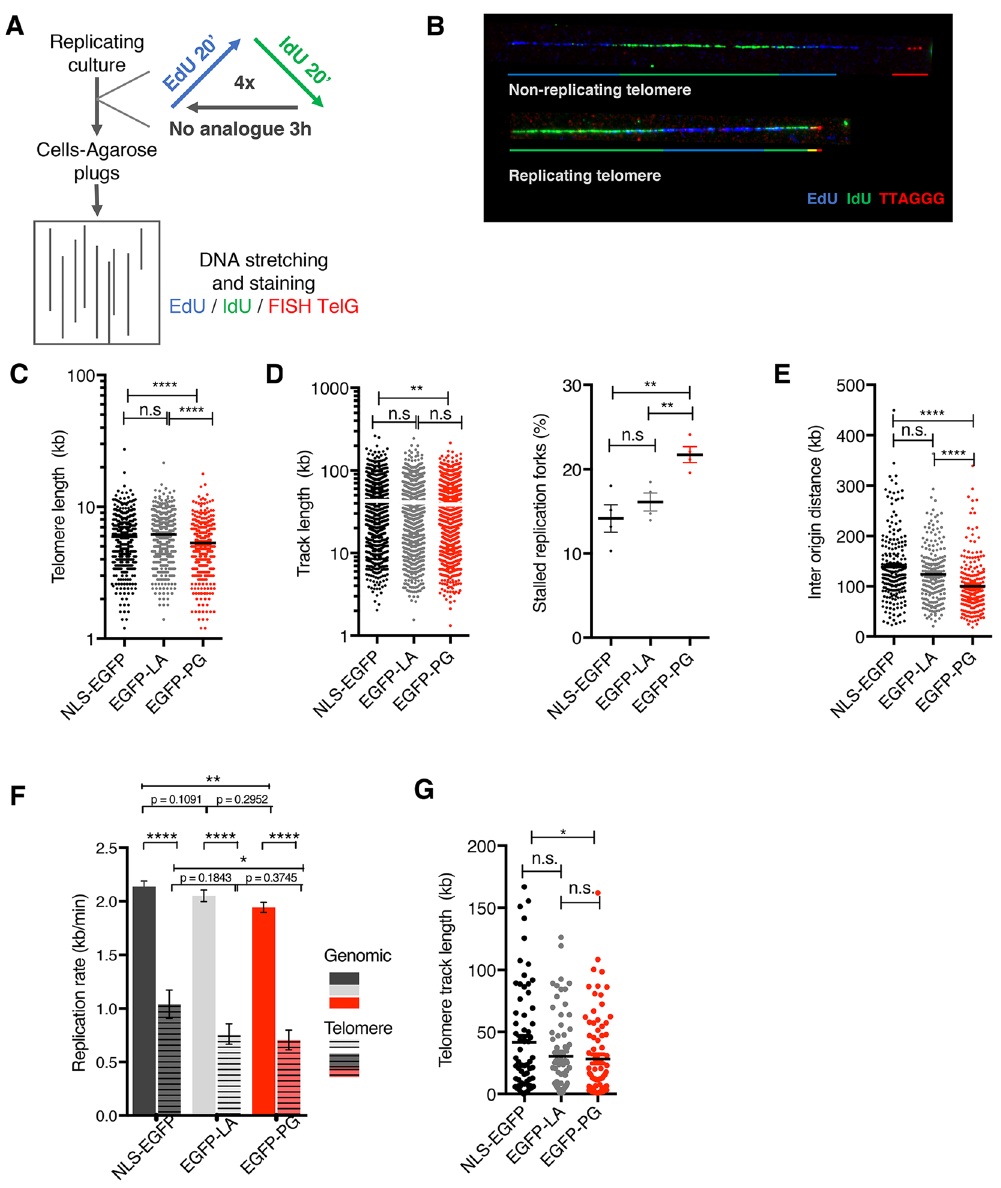
Figure 5. Fork progression is impaired genome-wide and at telomeres in progerin-expressing cells. ( A ) Principle of the SMARD experiment. HDF cells expressing NLS-EGFP, EGFP-LA and EGFP-PG were pulsed successively four times with the thymidine analogues EdU and IdU, followed by a chase period. Cells were collected and embedded in agarose in plugs before stretching the DNA fibers onto glass coverslips. Telomeres were visualized by FISH staining and EdU and IdU by immunofluorescence. ( B ) Examples of fibers obtained by SMARD. A non-replicating telomere corresponds to a detected FISH signal away from the EdU and IdU signals. A replicating telomere corresponds to a FISH signal located at the end of the fiber and in continuity with EdU or IdU signals. ( C ) Distribution of telomere length measured from DNA fibers performed as in ( A ). The size of the FISH signal gives an approximation of the corresponding telomere length. Mean with SEM is shown, n = 3. Statistical significance was determined using t-test (****indicates p < 0.0001). ( D,E ) Quantification of SMARD analyses at the genome-wide level in HDF cells expressing NLS-EGFP, EGFP-LA and EGFP-PG. ( D ) the graphs represent the replication track lengths (left), and the percentage of stalled replication forks in each replicate (right). ( E ) Inter Origin Distance (IOD). ( F ) Quantification of SMARD analyses at telomeres and genomic regions from HDF cells expressing NLS-EGFP, EGFP-LA and EGFP-PG. The graph represents the rate of genomic versus telomere replication. ( G ) Quantification of SMARD analyses at telomeres from HDF cells expressing NLS-EGFP, EGFP-LA and EGFP-PG. The graphs represent the telomere track length. ( D–G ) Mean with SEM is shown, n = 3. Statistical significance was determined using t-test (*indicates p < 0.05, **indicates p < 0.01, ****indicates p <